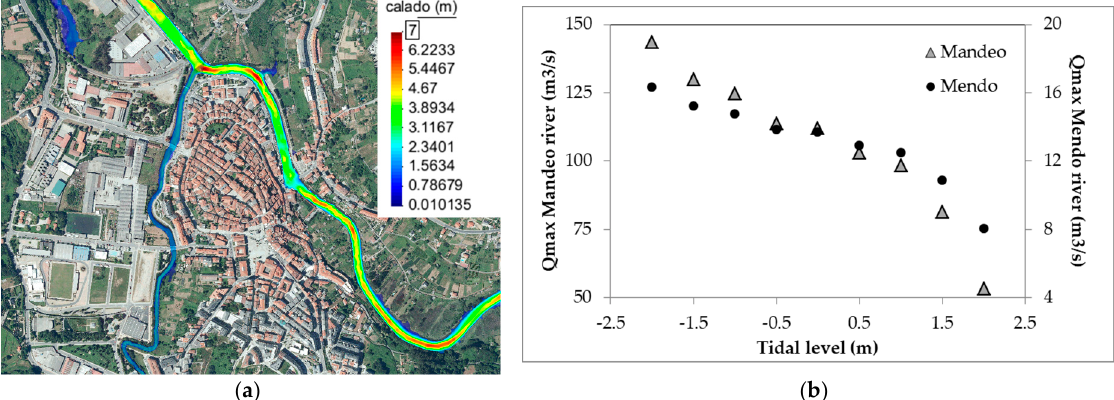
Figure 1. ( a ) Example of water depth fields before flow exceeds the waterway ( b ) Maximum discharges obtained for the simulated tidal